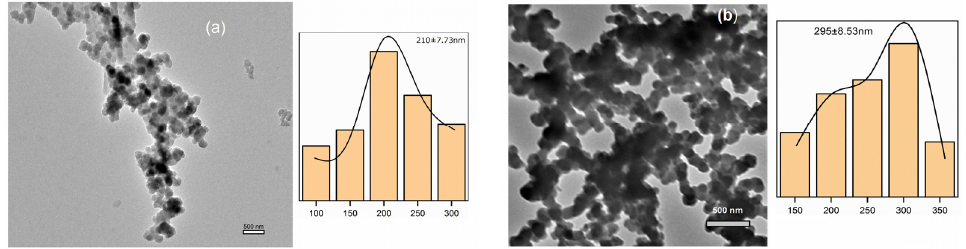
Figure 16. TEM images of functionalized organic-inorganic nano composite ( a )— (11) and ( b )— (12) .